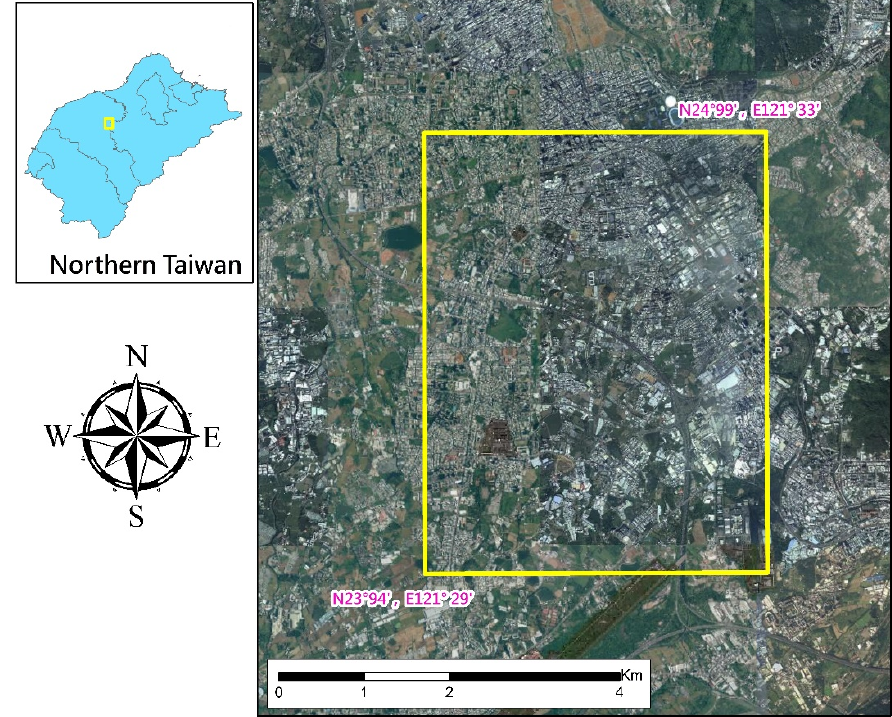
Figure 1. Flooding simulation area: the Dongmen drainage.